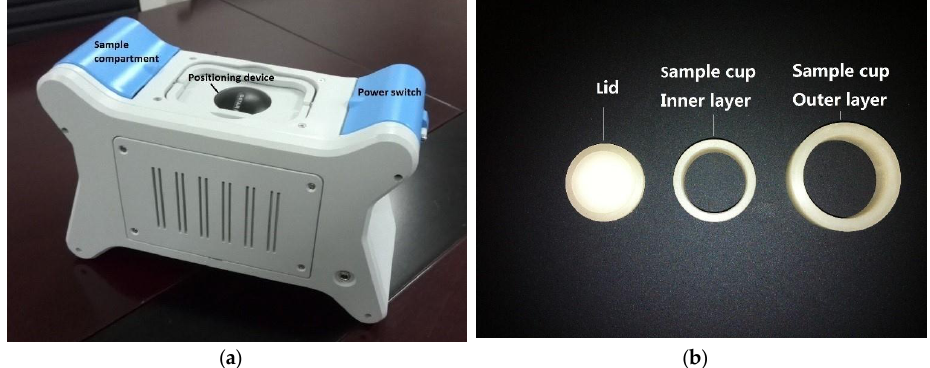
Figure 1. XRF spectrometer and sample cup used for detection in this study: ( a ) XRF spectrometer; ( b ) sample cup. The spectrometer can be used both in laboratory and in the field, linked with a laptop. A total of 111 samples were collected, including 46 national standard soil samples (National Standard Material Research Center, Beijing, China), 30 standard addition soil samples (collected from Heilongjiang, Yunnan, Jiangsu and Xinjiang provinces from typical soil, namely, black soil, paddy soil, red soil, and brown soil), and 35 natural soil samples (collected from around Beijing) from the soil surface of farmland at a depth of 0–20 cm. The samples were preserved after air-drying, ground, and sieved with a nylon mesh indoors. The standard additional soil samples were mixed with the appropriate metal salts over a range of concentrations by serial dilution. All the tools used during the processing were made of ceramic or agate to ensure no interfering XRF signals at the tested heavy metal peak energies. Analysis of the HMs in the soil samples was performed in accordance with national standards, including the national standard soil samples (GSS-4) for quality control; three spectra were collected for each sample. The content of chromium (Cr), copper (Cu), zinc (Zn), lead (Pb) were determined with a Solaar-M (Thermo Fisher Scientific Inc., Waltham, MA, USA) atomic absorption graphite furnace. Arsenic (As) content was tested with a AFS-830 (Jitian Instrument Inc., Beijing, China) atomic fluorescence analyzer.